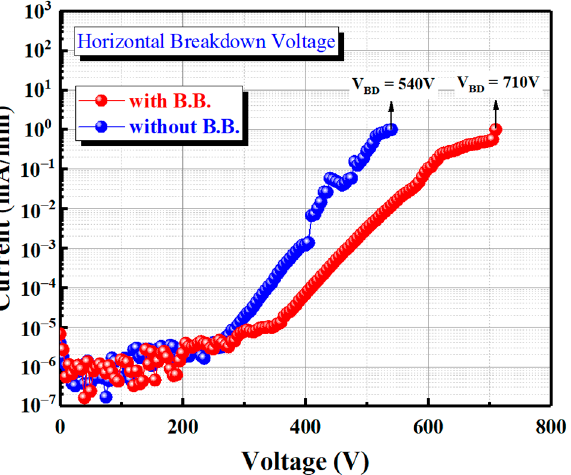
Figure 7. The horizontal breakdown characteristics of devices with, and without, BB.